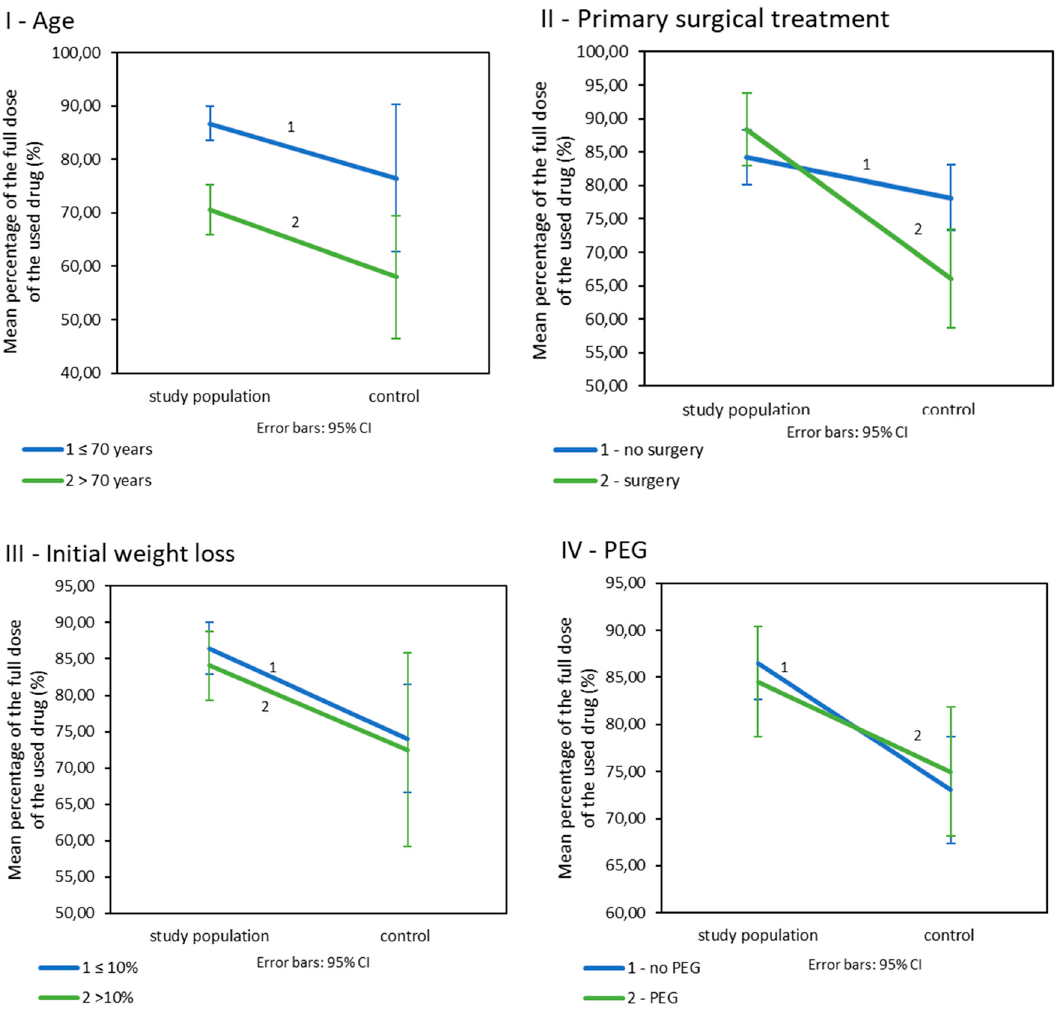
Figure 3. The percentage of the drug’s planned dose used in CRT/BRT in the study and control population by ( I ): age. ( II ): primary surgical treatment. ( III ): initial weight loss. ( IV ): prophylactic PEG placement, ( n =